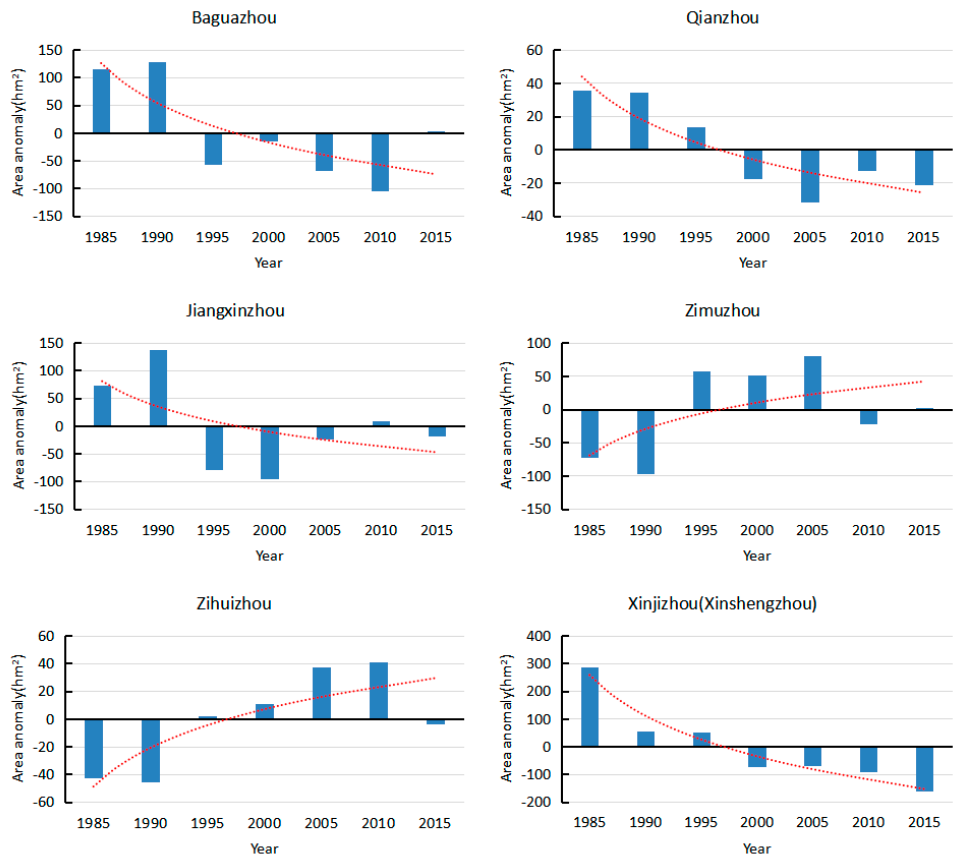
Figure 7. Area anomaly of each island in the study area (hm 2 ).